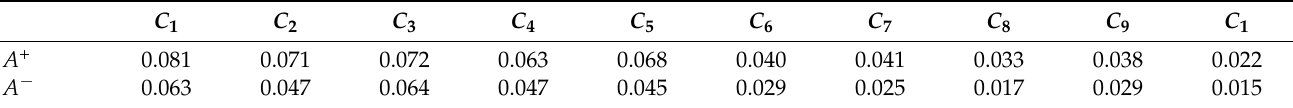
Table 8. Values of A + and A − of criteria elements.